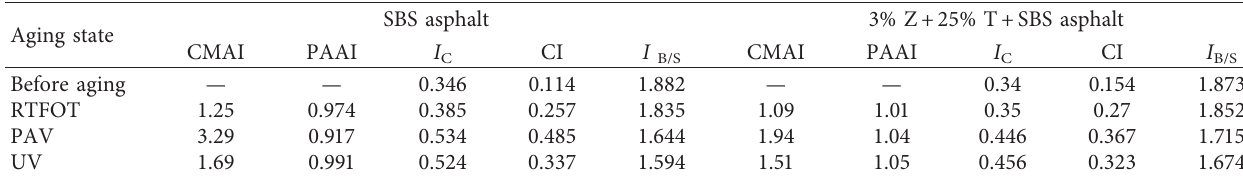
Table 7: Summary of experimental